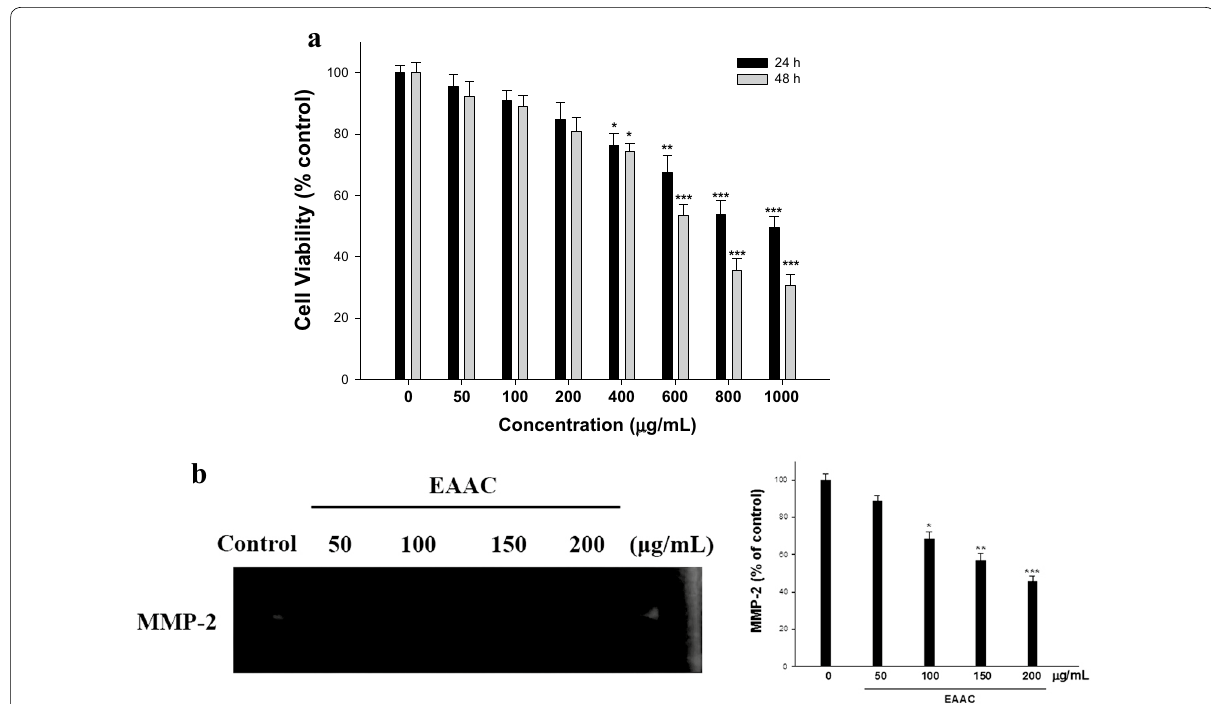
Fig. 2 Effects of EAAC on SK‑Hep1 cell viability ( a ) and MMP‑2 ( b ) activity. The cells were incubated for 24 and 48 h in the absence or present of EAAC (0, 50, 100, 150, and 200 μg/mL). After treatment, cell viability assay was performed using MTT assay. Optical density was determined at 570 nm and is expressed as cell survival relative to control. Cells were treated with various concentrations of EAAC for 24 h. The conditioned media were collected, and MMP‑2 activity was determined by gelatin zymography. MMP‑2 activity was quantified by densitomeric analysis. The data were presented as mean SD for three different experiments performed in triplicate. * p < 0.05, ** p < 0.01, and *** p < 0.001 was compared with ± untreated control